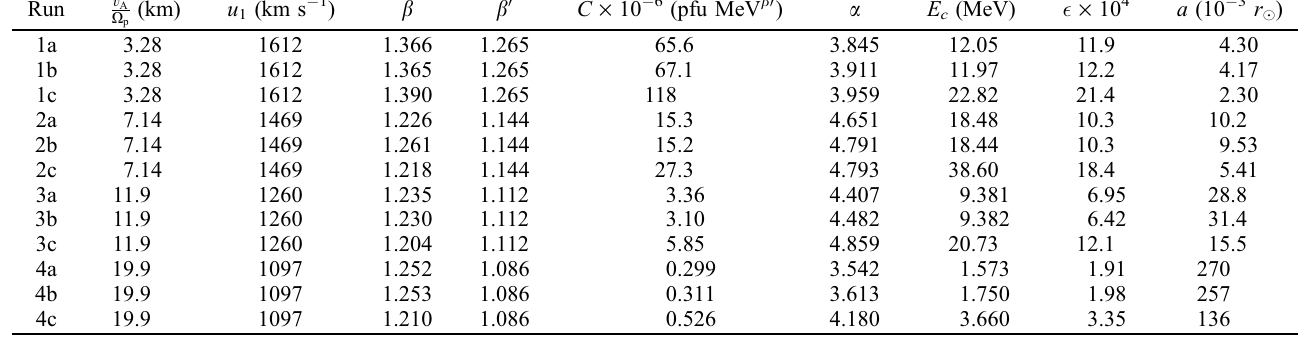
Table 2. Simulation results. The unit of intensity is pfu ¼ cm (cid:3) 2 sr (cid:3) 1 s (cid:3) 1 MeV (cid:3) 1 .